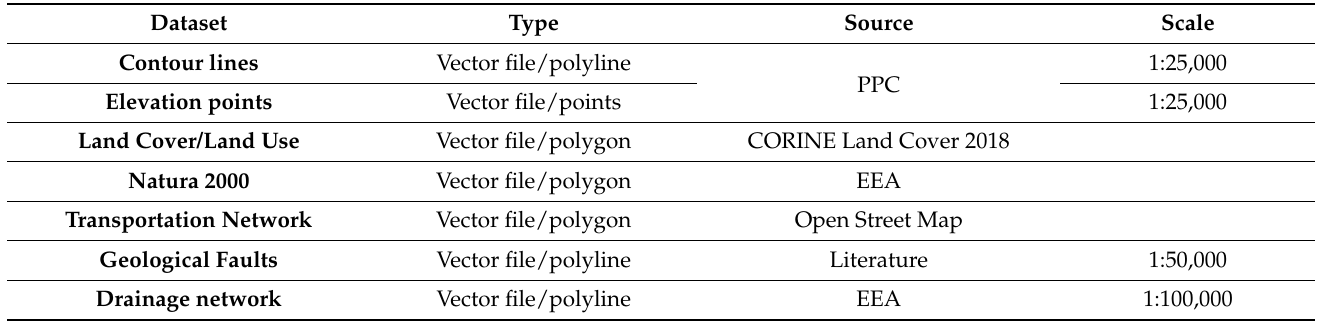
Table 1. Descriptive characteristics of the processed